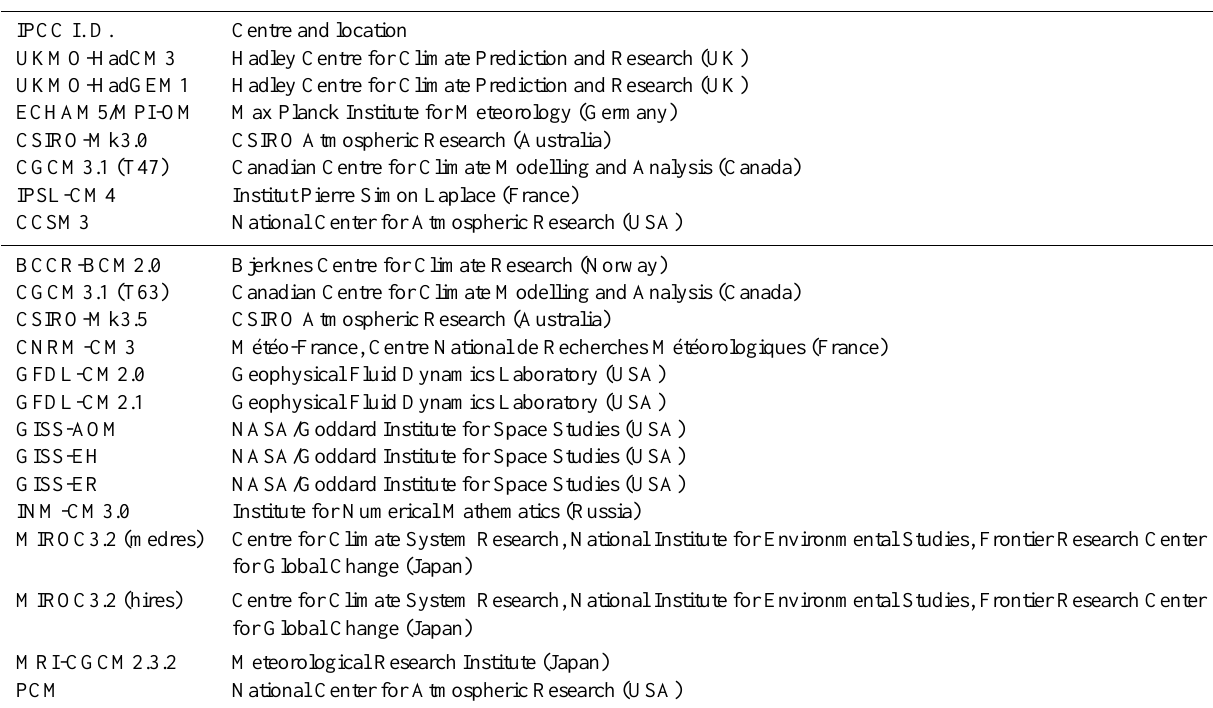
Table 3. CMIP3 models used to define climate projections (see Meehl et al., 2007 for full references). IPCC I.